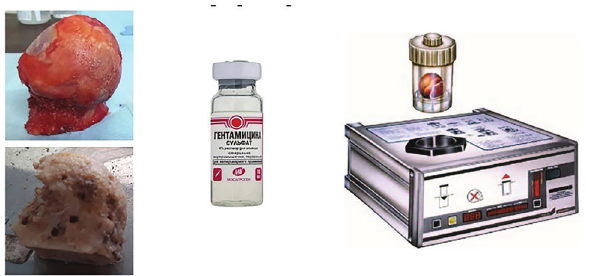
Figure 8 - Antibiotic treatment of the whole femoral bone head in the Lobator sd-2